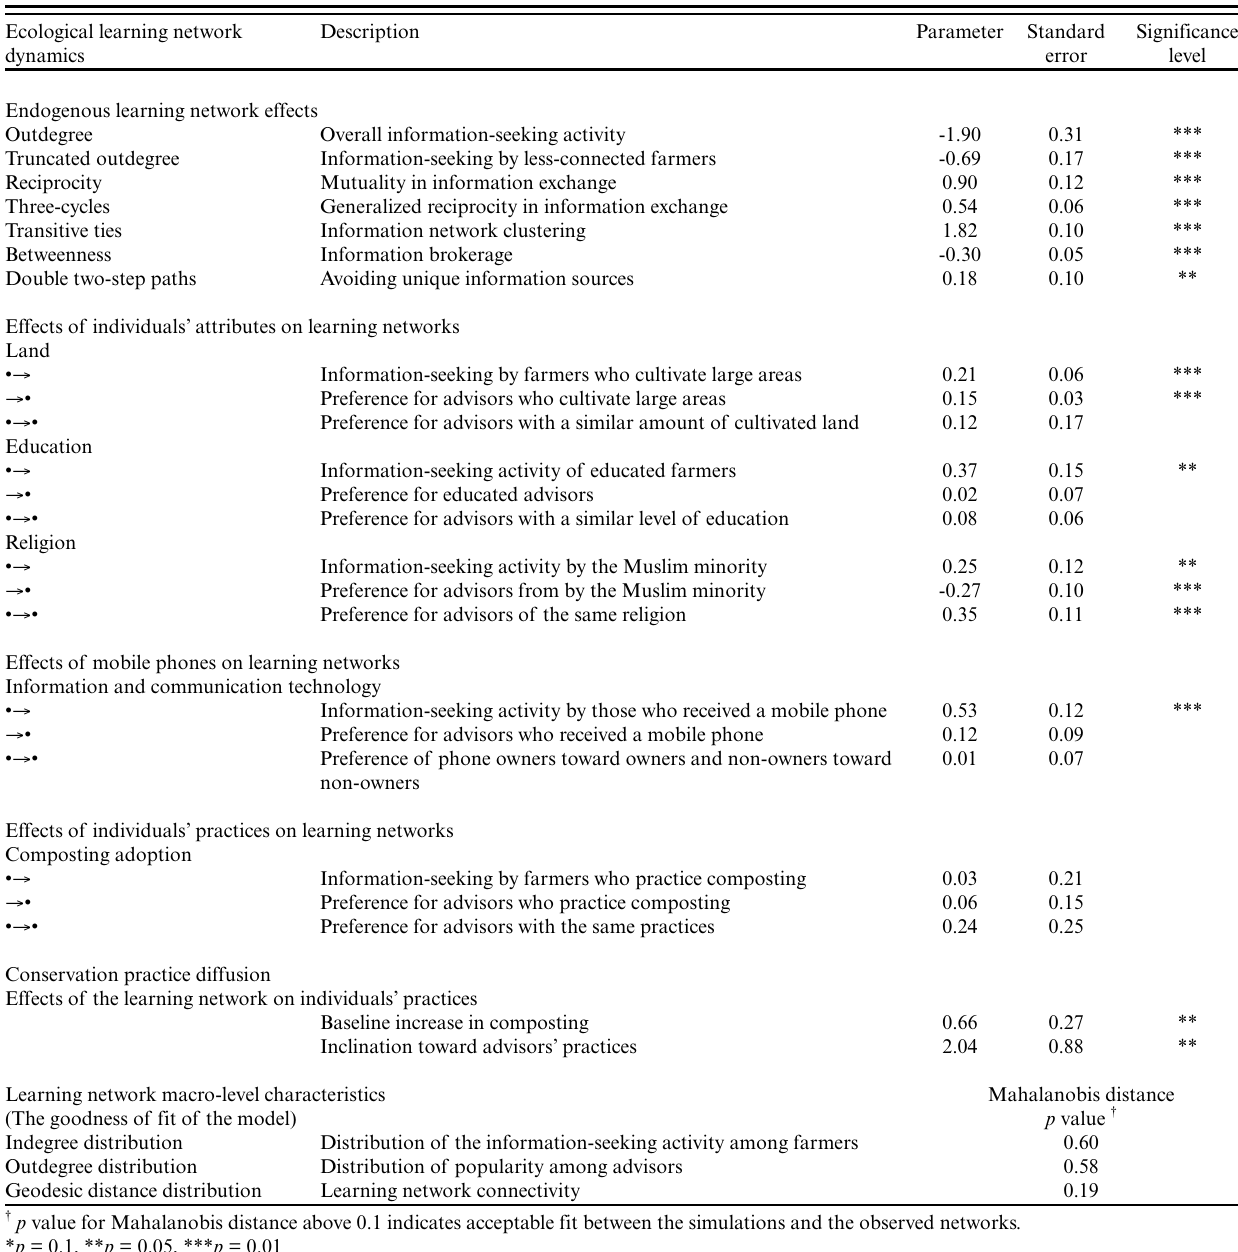
Table 3 . Dynamics of the network and the practice of